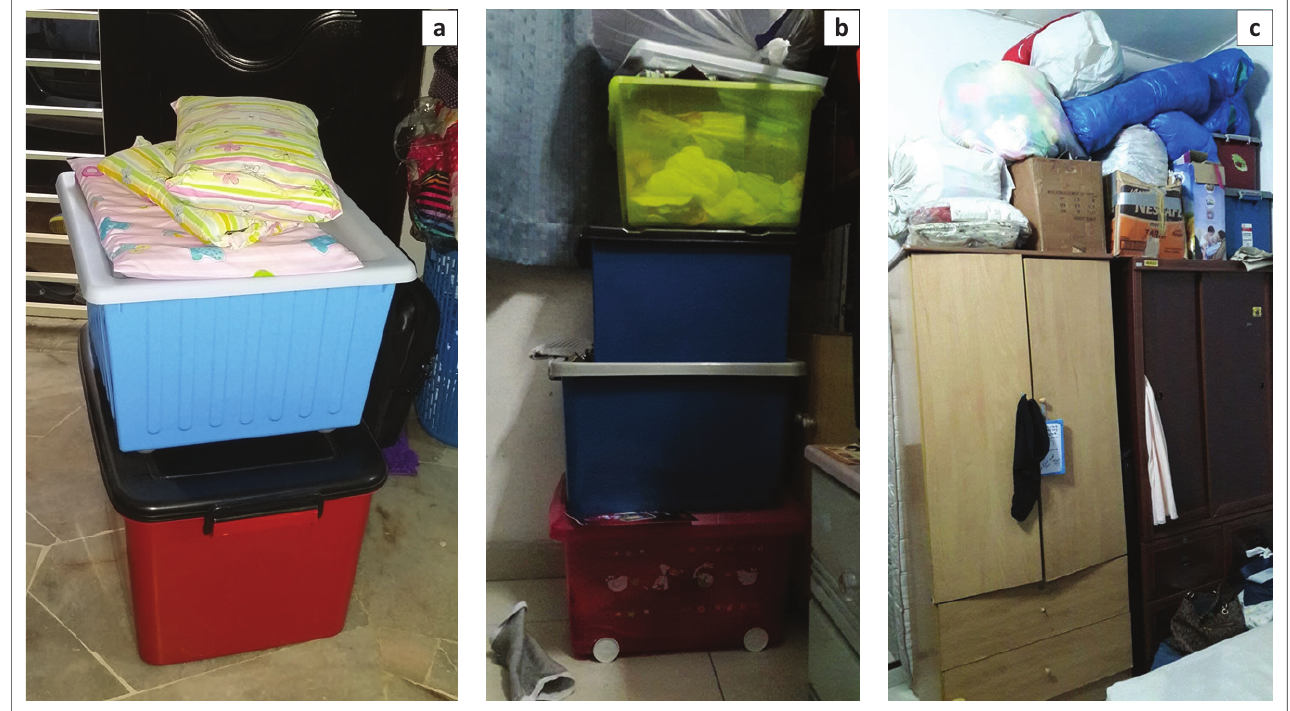
FIGURE 5: Normal practice in Malaysia. Optimising the space by (a and b) stacking and (c) putting important belongings in plastic containers either in the house or to keep at a neighbour’s house (subject to available space and permission of owner of the house) for 2–3 months.